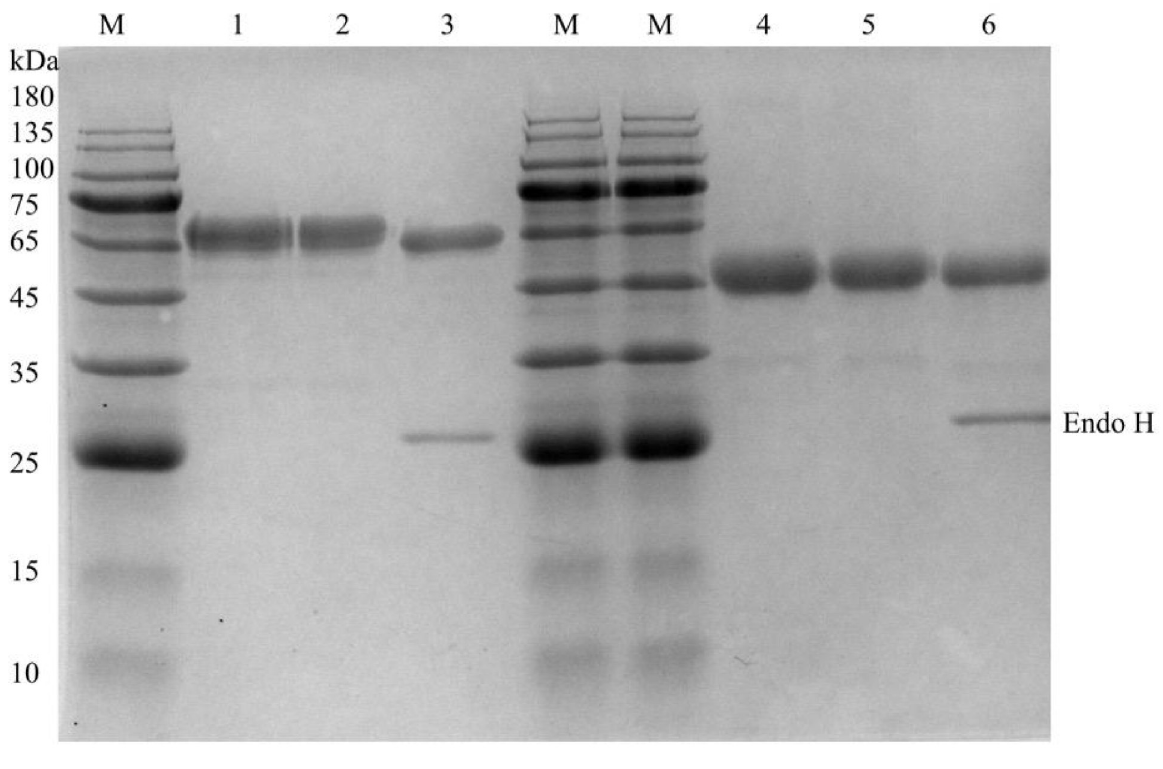
Fig 1. SDS-PAGE (12% polyacrylamide gel) analysis of the purified recombinant Tl Cel5A and Tl Cel6A. Lane M, the molecular mass standards; lane 1, the culture supernatant of Tl Cel6A; lane 2, the purified recombinant Tl Cel6A; lane 3, the deglycosylated Tl Cel6A with Endo H treatment; lane 4, the culture supernatant of Tl Cel5A; lane 5, the purified recombinant Tl Cel5A; lane 6, the deglycosylated Tl Cel5A with Endo H